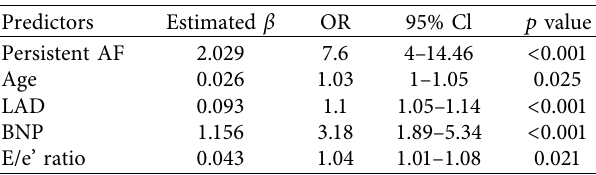
Table 2: Predictors of LA/LAA thrombi screened by multivariate logistic regression.